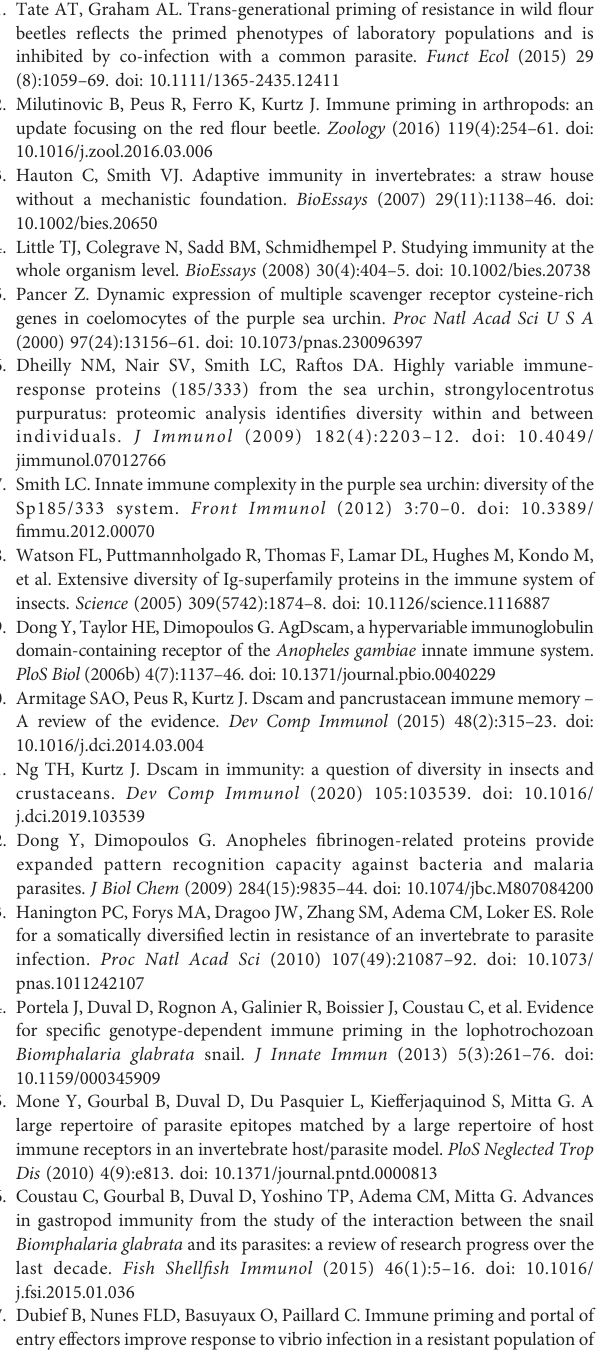
challenged group and control group is indicated by * at p < 0.05. EF1- a served as a reference gene. SUPPLEMENTARY FIGURE 4 | Expression of AMP genes in the hepatopancreas after the IPP and ICP. The x - axis denotes hours after bacterial injection [IPP (6, 9, and 72 h) and the ICP (174, 177, and 240 h)]. The y -axis re fl ects expression of genes of members of the TLR signaling pathway. The signi fi cant difference between the challenged and control groups is indicated by * at p < 0.05. EF1- a served as a reference